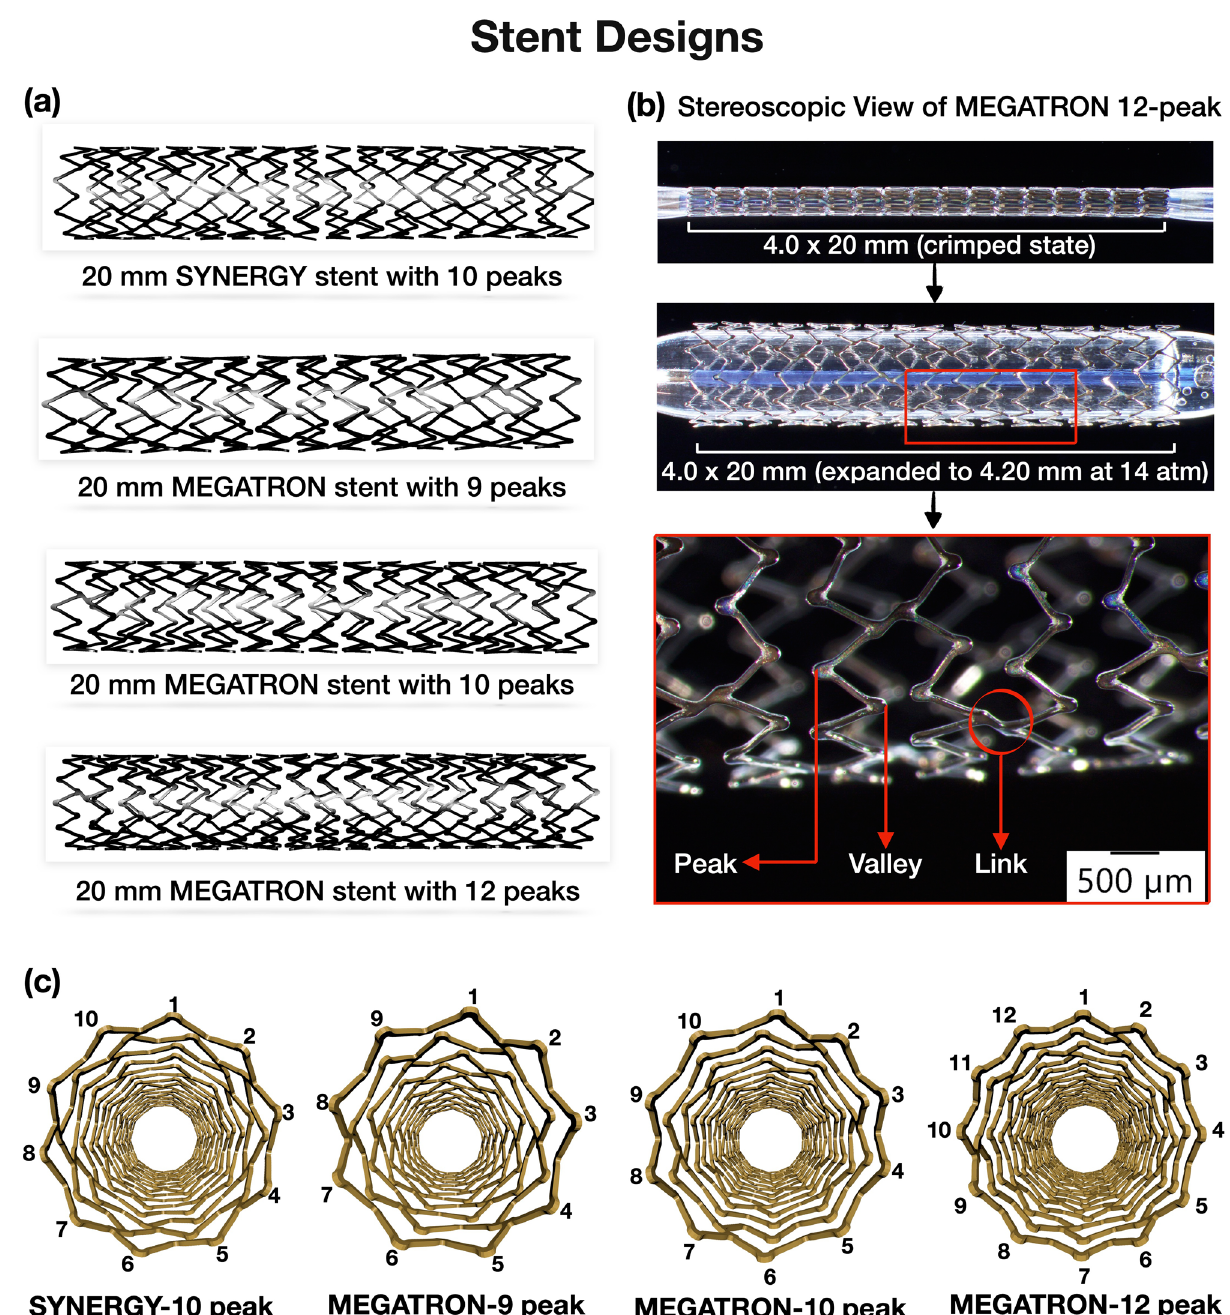
Figure 2. Stent designs. ( a ) Everolimus-eluting stent designs used in the computational and experimental testing: 9-peak, 10-peak, 12-peak MEGATRON and SYNERGY, ( b ) Stereoscopic view of crimped and expanded 12-peak MEGATRON stent. Note the stent struts peaks, valleys and links, ( c ) Cross-sectional configuration of the n = 4 stents.